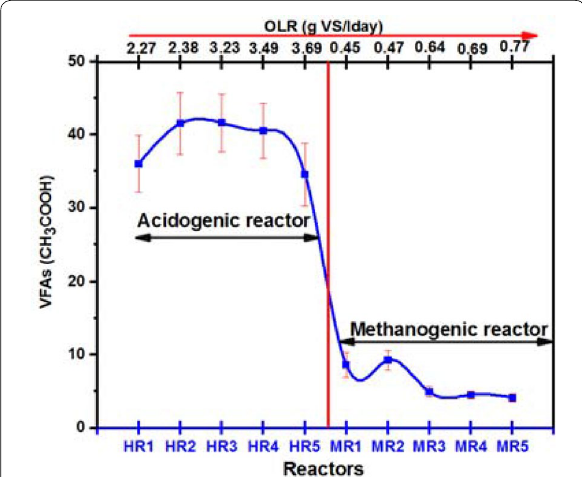
Fig. 2 Mean VFAs and standard error variations with OLR of the acidogenesis stage